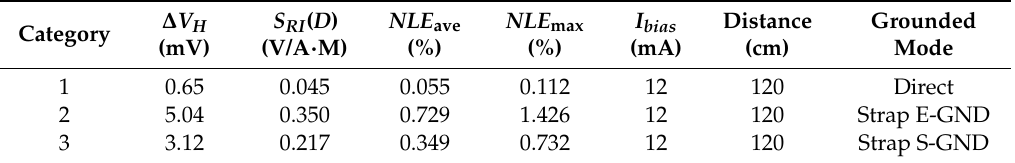
Table 2. Measurements of maximum output Hall voltages,